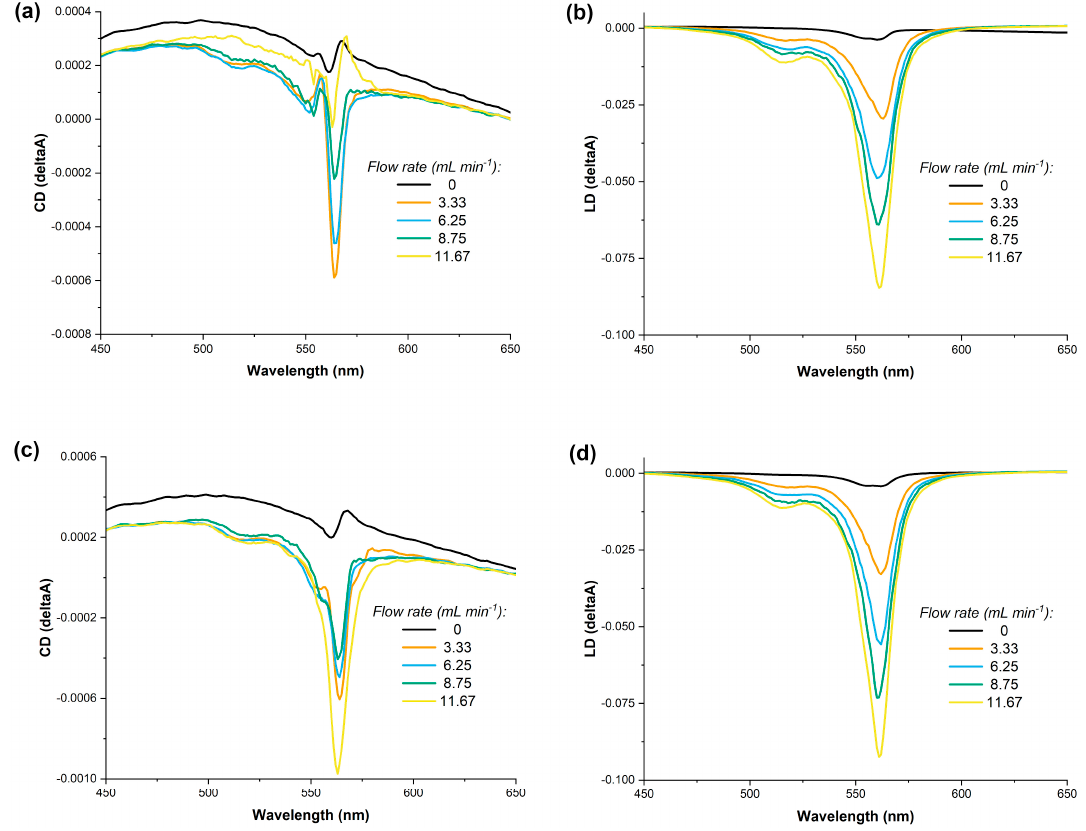
Figure 5. The dependence of the LD and CD of a solution of S0271 in Milli-Q water (pH 7.12, 18.2 Ω 18.2 Ω cm − 1 ) at 20 µ M on the rate of a constant laminar flow, panels ( a , b ) no stirring and, cm − 1 ) at 20 µM on the rate of a constant laminar flow, panels ( a ) and ( b ) no stirring and, panels ( c ) panels ( c , d ) with stirring in situ at 400 rpm, all recorded at 21 ◦ and ( d ) with stirring in situ at 400 rpm, all recorded at 21 °C.